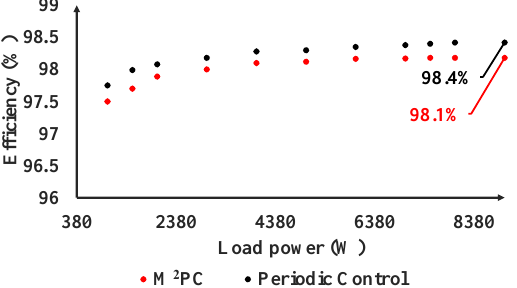
Figure 10. Measured efficiency of the three-phase VSC using the fixed switching frequency schemes, feeding a linear